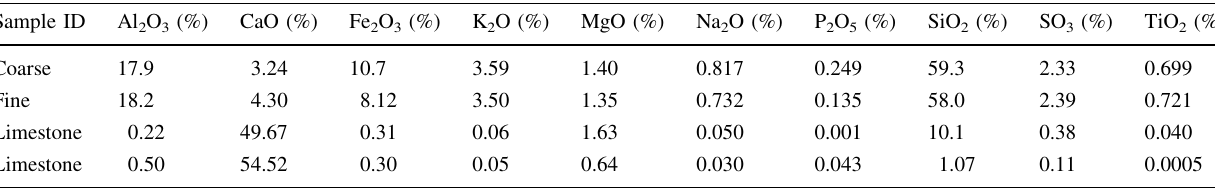
Table 3 Comparison of major elements in coal waste HTA and ground limestone